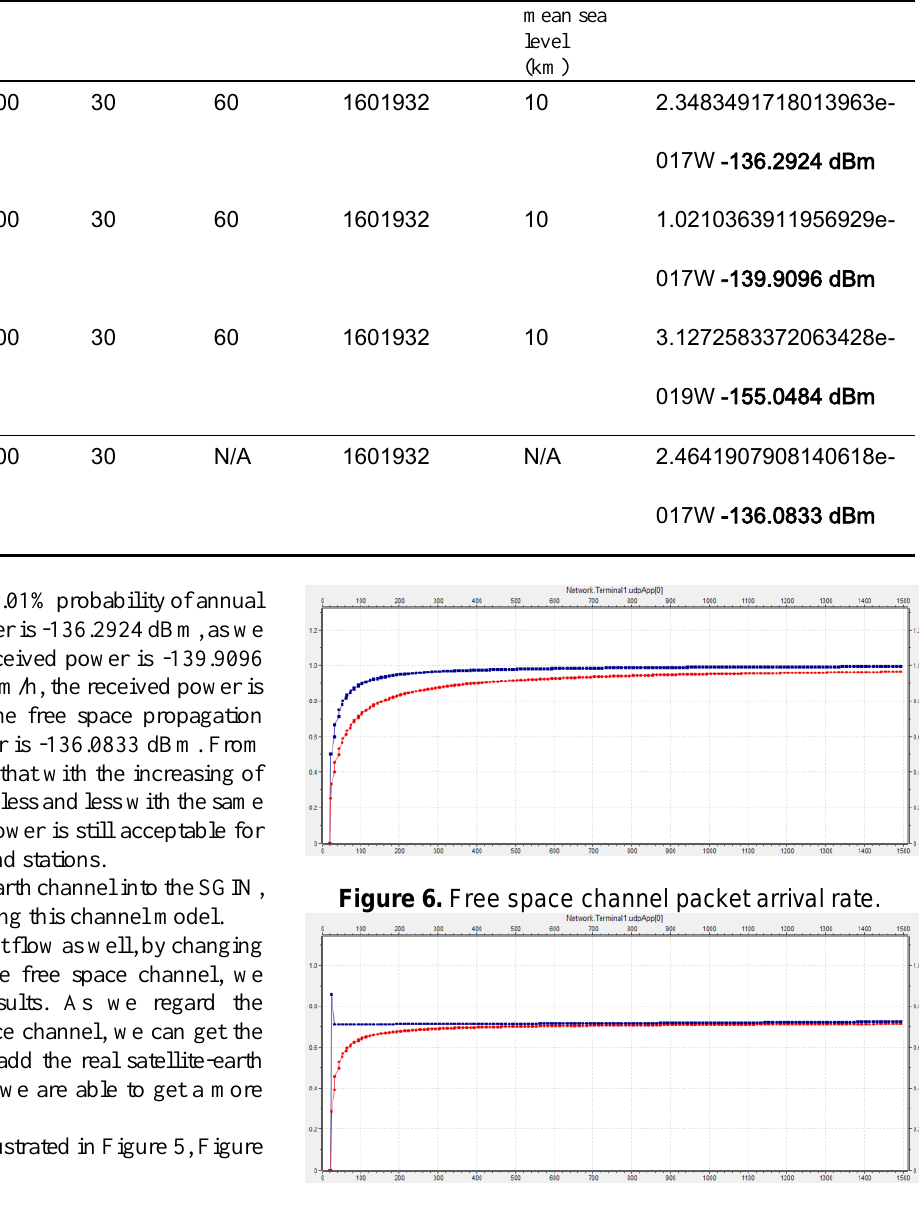
Figure 7. Satellite-earth link channel packet delay.